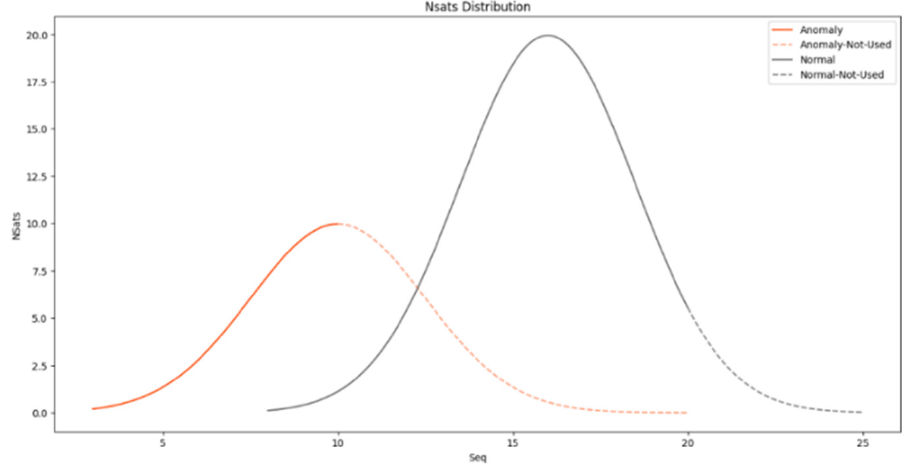
Figure 7. 𝑓(cid:4666)𝑥(cid:4667) under normal and abnormal GPS conditions Figure 7. f ( x ) under normal and abnormal GPS